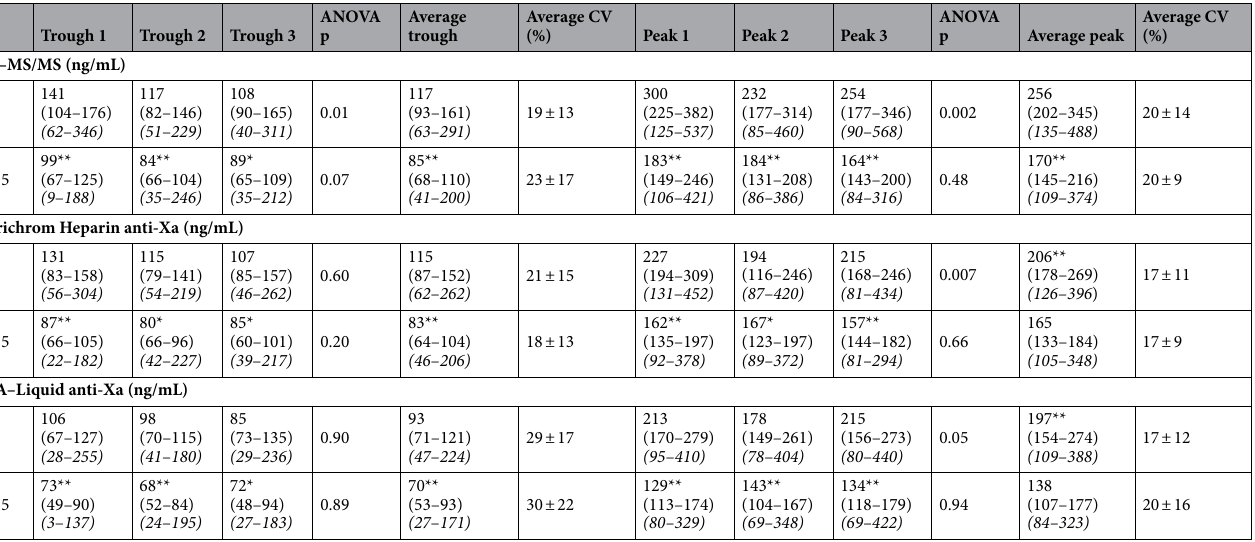
Table 2. Apixaban measurements in three peak and three trough samples in patients on apixaban 5 mg (A5) or 2.5 mg (A2.5) twice-daily with the corresponding intra-individual coefficient of variation (CV). Results are shown as median with first to third quartile (roman font) and minimum to maximum range (italic font). ** p < 0.01, * p < 0.05 for Mann–Whitney comparison between patients on A5 and A2.